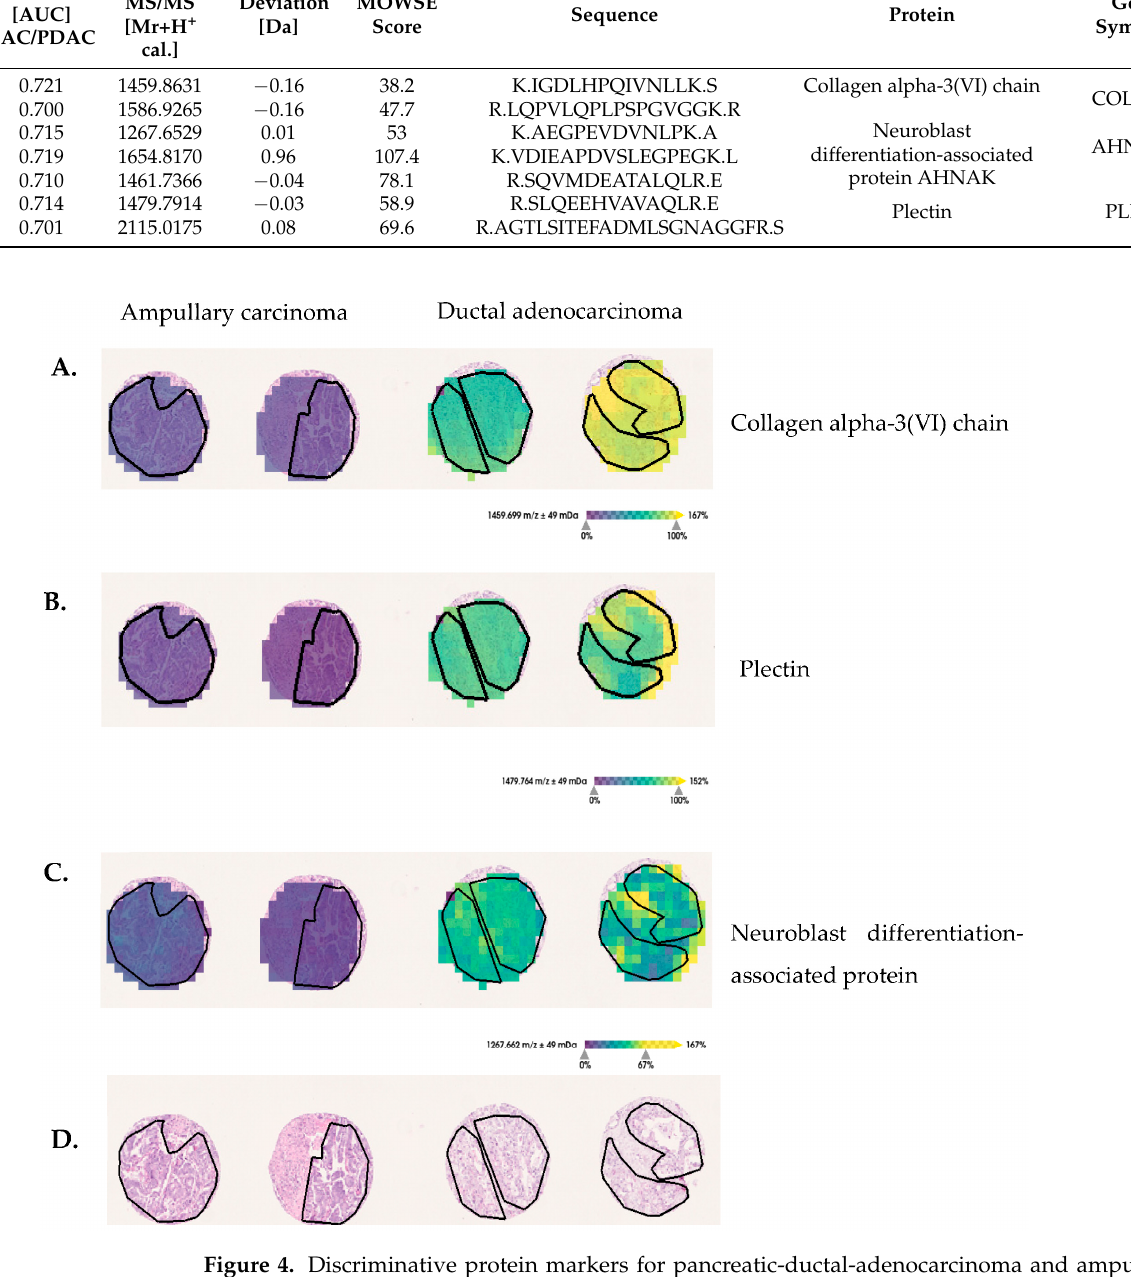
Figure 4. Discriminative protein markers for pancreatic-ductal-adenocarcinoma and ampullary-carcinoma tissue sections. ( A ) The m/z 1459 Da assigned to COL6A3, ( B ) m/z 1479 Da assigned to PLEC and ( C ) m/z 1267 Da assigned to neuroblast differentiation-associated protein show increased intensity-distributions in ductal adenocarcinoma, in comparison with ampullary-carcinoma tumor regions (black lines delineate tumor-border area). ( D ) For orientation, hematoxylin and eosin (H&E) staining are provided.